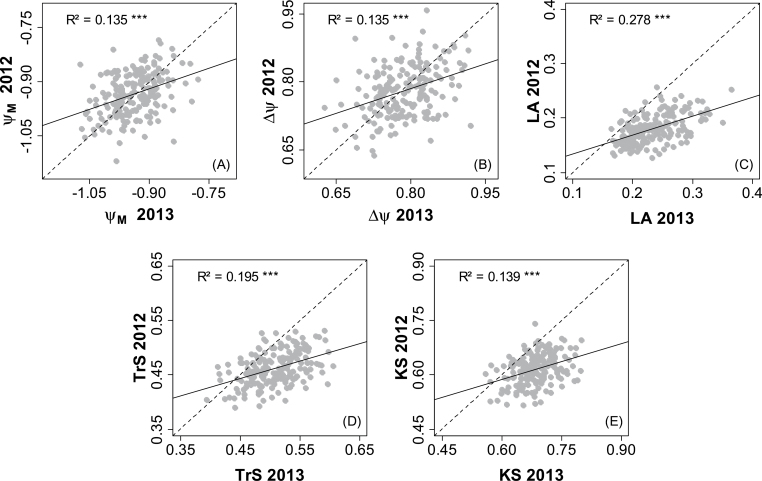
Comparison between 2012 and 2013 for mean genotypic values of hydraulics-related traits estimated under water deficit conditions for each offspring of the Syrah×Grenache mapping population. See Table 1 for abbreviations (ΨM in MPa, ∆Ψ in MPa, TrS in mmol m–2 s–1, KS in mmol m–2 s–1 MPa–1, LA in m2). n=188 for each year and each trait. Pearson’s determination coefficients are given, with *** indicating high statistical significance (P≤10–9). Regression lines are represented in black and bisecting lines in grey.